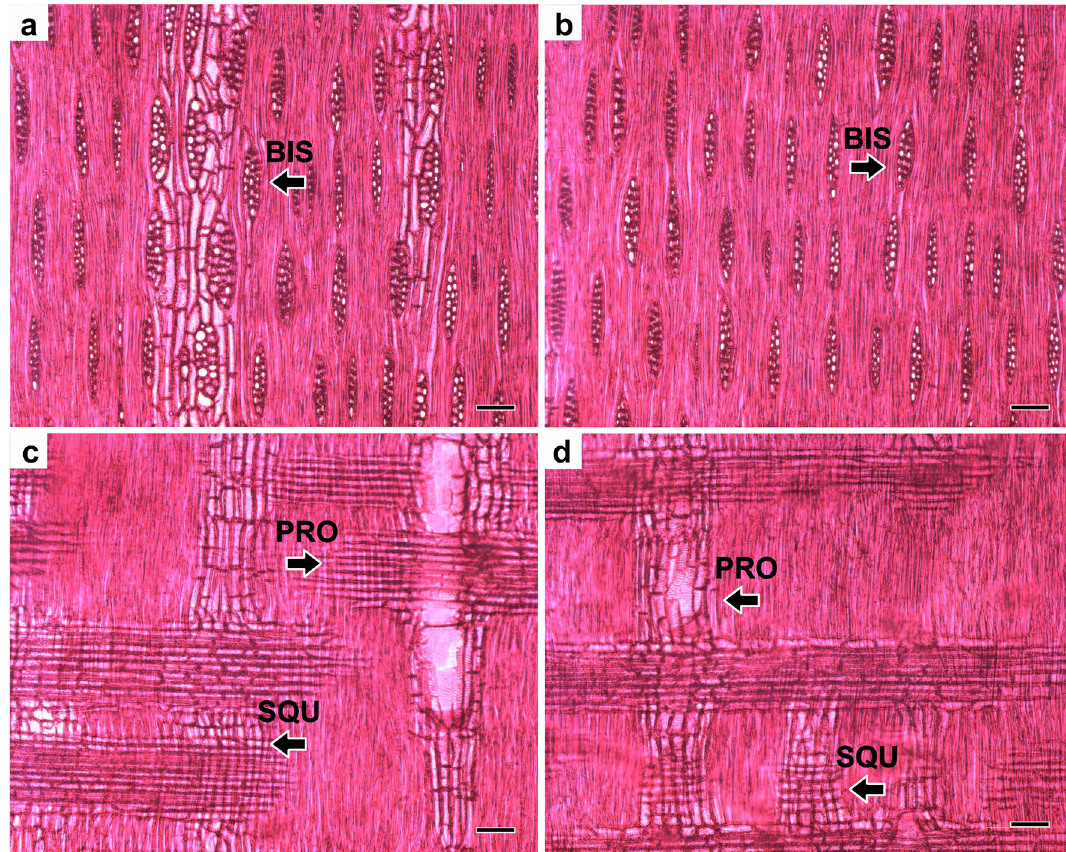
Figure 5. Tangential section from base ( a ) and top ( b ) of the tree, and radial section from base ( c ) and top ( d ) with emphasis on: heterogeneous and biseriate rays (BIS) with procumbent (PRO) and square cells (SQU). Scale bars = 100 μm.